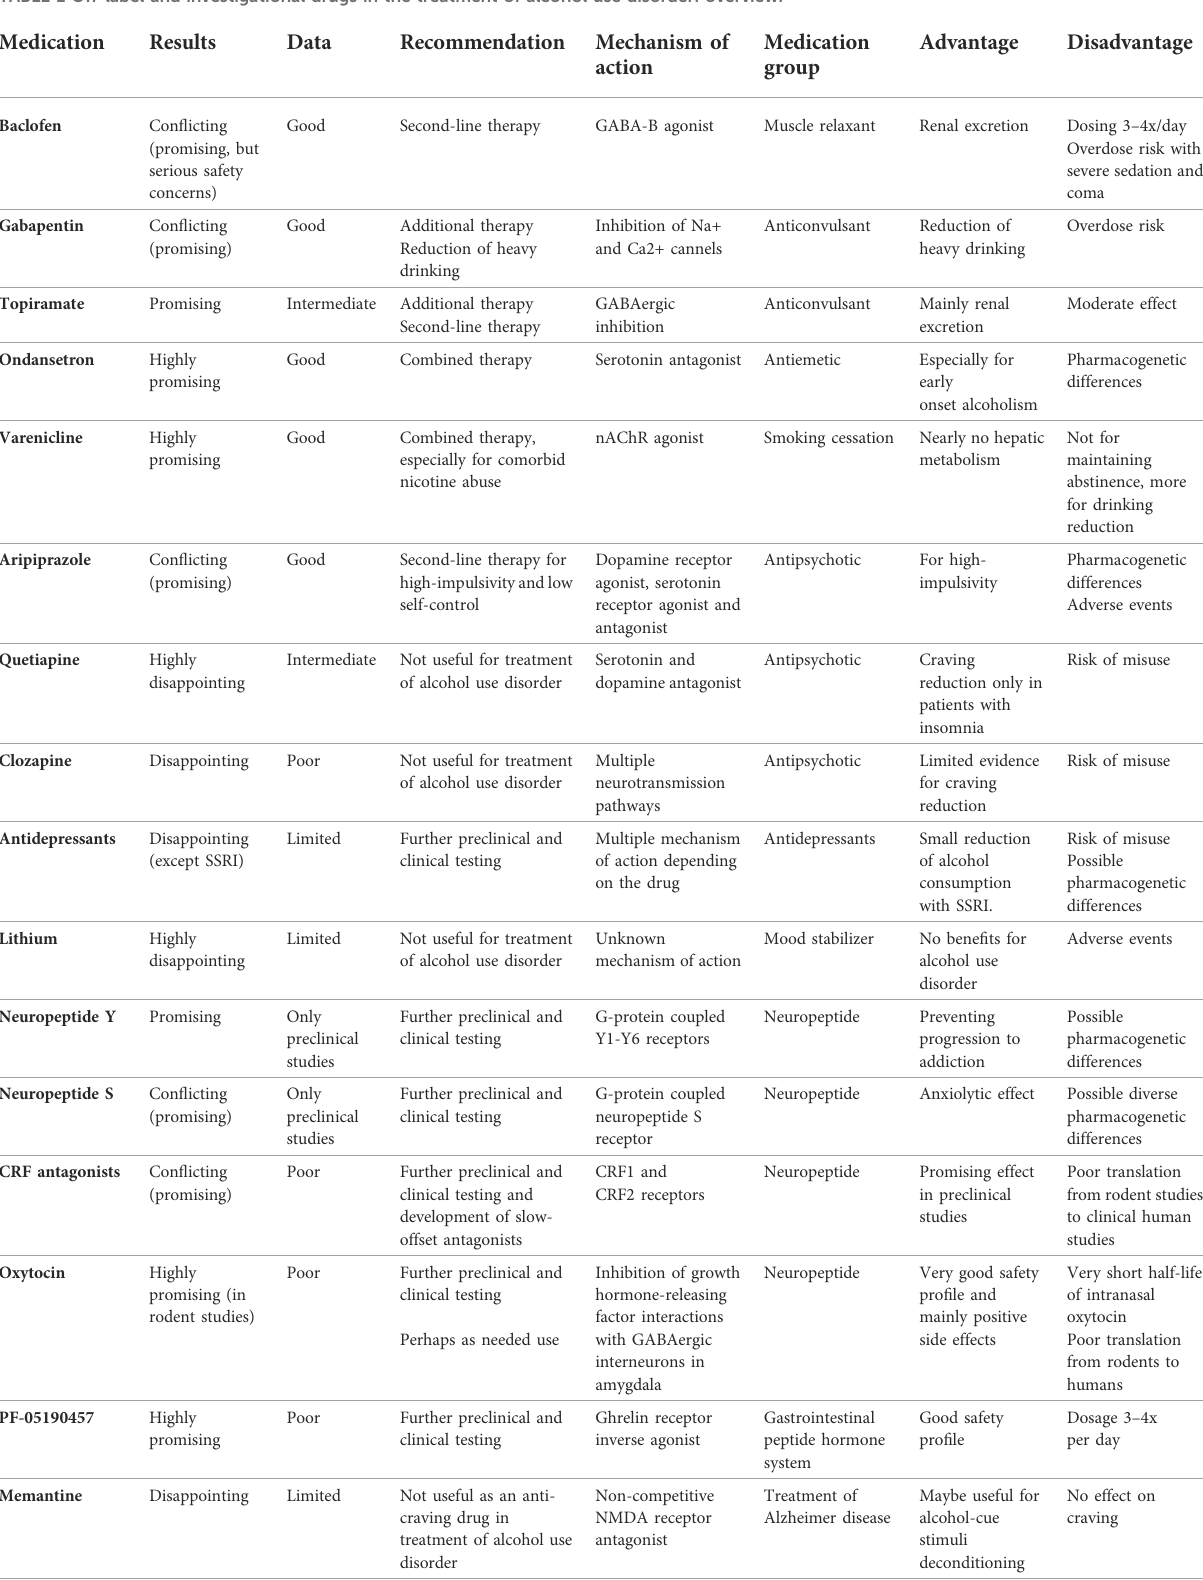
TABLE 1 Off-label and investigational drugs in the treatment of alcohol use disorder: